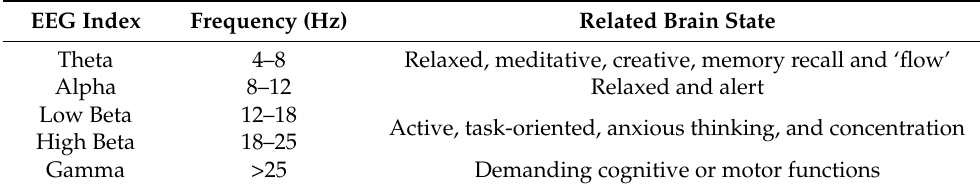
Table 3. EEG indexes used in this study and their related frequencies and brain states [59].